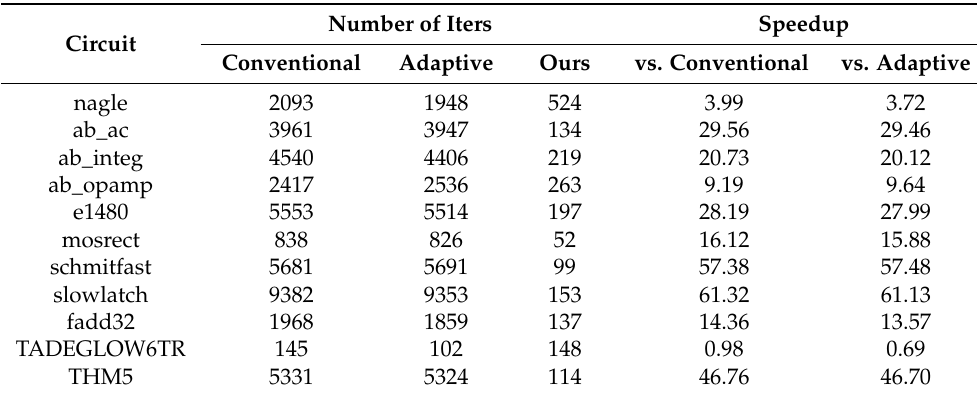
Table 3. Simulation efficiency for DPTA.